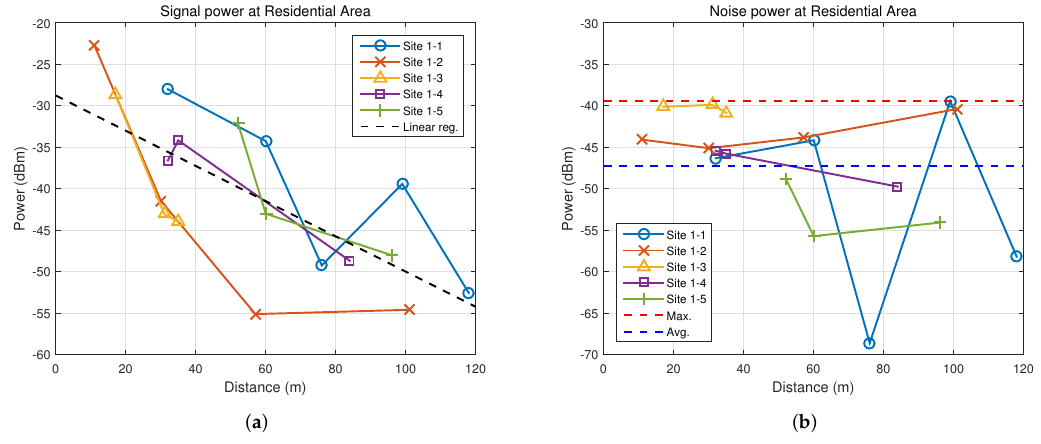
Figure 20. Overhead Residential Area. ( a ) Received power. ( b ) Noise